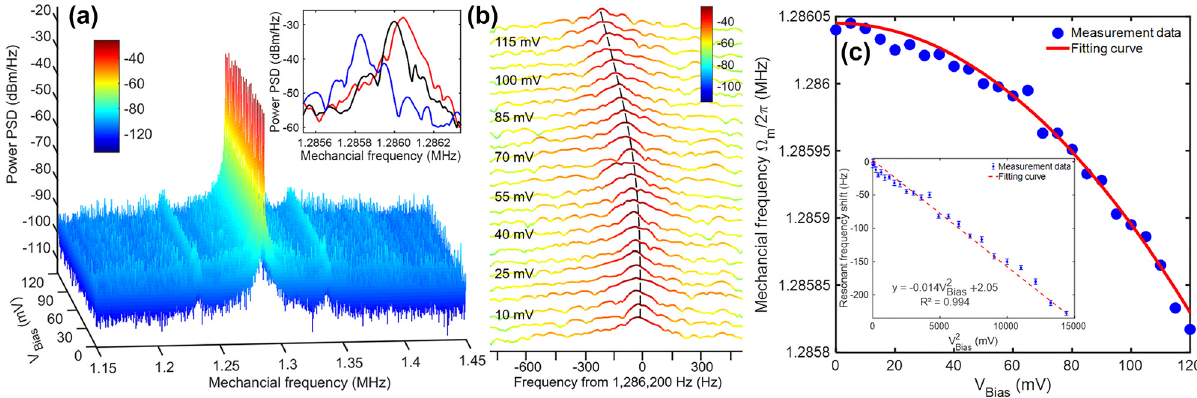
Figure 8: Bias voltage detection in the optomechanical electrometer above threshold power. (a)RFspectraabovethresholdpowertrackedformeasurementoftheappliedbiasvoltagefrom0mVto120mV.Insetisthezoom-inviewofthe resonance peak area to observe the shift of mechanical frequency at 0 mV (red), 60 mV (black) and 120 mV (blue). (b) Zoom-in view of the spectraat theresonancepeak areaas a function of the appliedbias voltages. The black dashedcurveindicates thevariationof theresonance peaks.(c) Mechanical resonantfrequencyversusappliedbias voltages. Insetis the measureddata converted to a linearrelationship between resonance shift and applied voltage